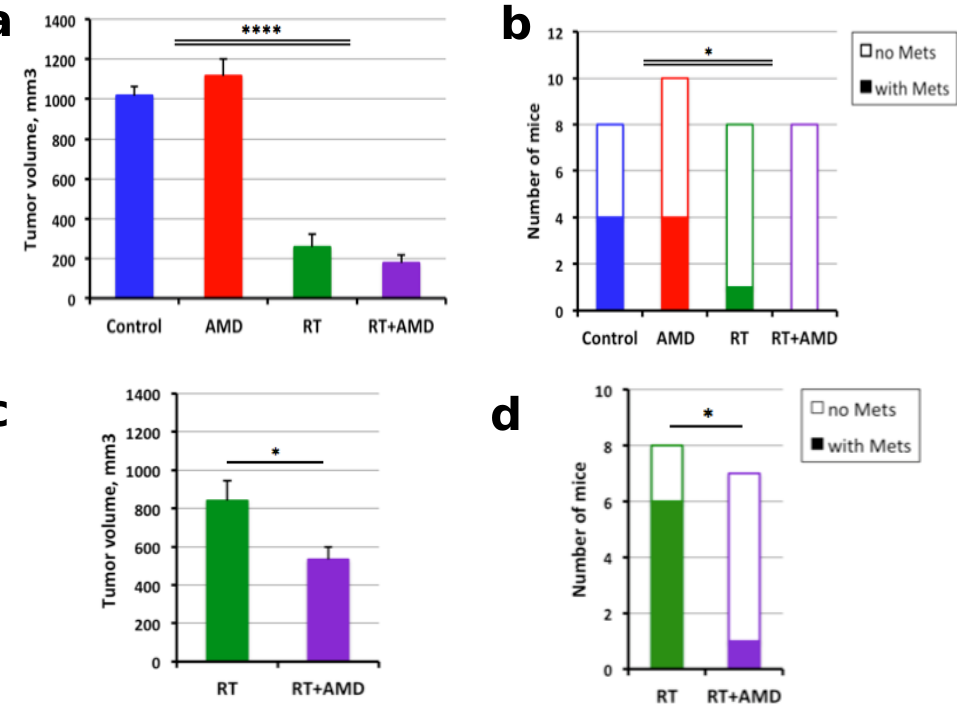
Figure 3. Efficacy of CXCR4 inhibition added to RT in nude mice bearing orthotopic human C4-2B PCa xenografts. ( a , b ) Tumor volume ( a ) and the fraction of mice with LN metastasis ( b ) 28 days after radiotherapy (RT) at a single dose of 12 Gy and/or the initiation of 2-week AMD3100 (AMD) treatment. ( c , d ) The long-term effects of combination therapy on primary tumor volume ( c ) and LN metastasis ( d ), in the same model, at day 60. * p < 0.05; **** p < 0.0001.